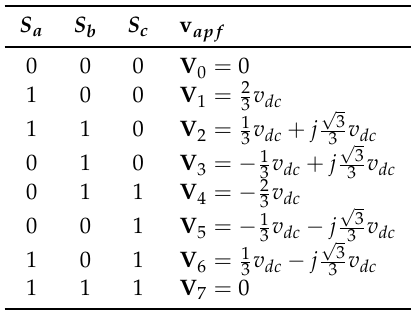
Table 1. Switching states and voltage vectors.